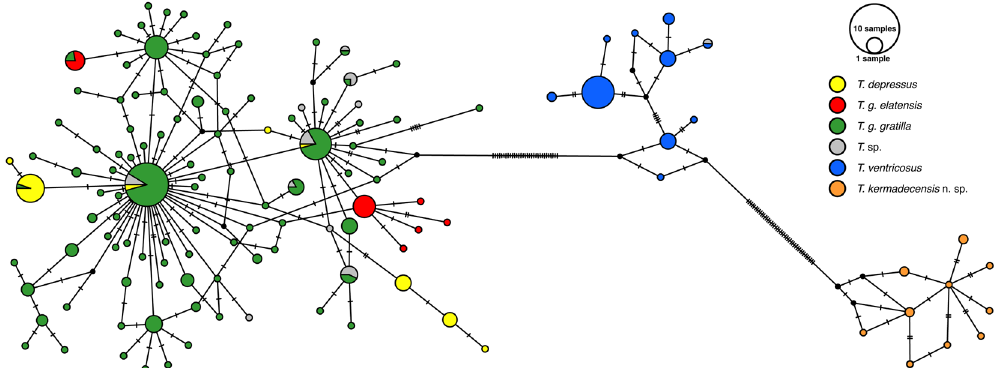
Figure 7. Tripneustes COI Median-joining haplotype network. The network comprises 339 sequences, 448 bp long, generated during the current study as well as comparable Tripneustes COI sequences available from GenBank (for details see Supplementary Tables S1 and S2). Color code as in Fig. 5. Bars indicate the number of substitutions between nodes. The frequency of each haplotype is indicated by size of the circles (see key, top